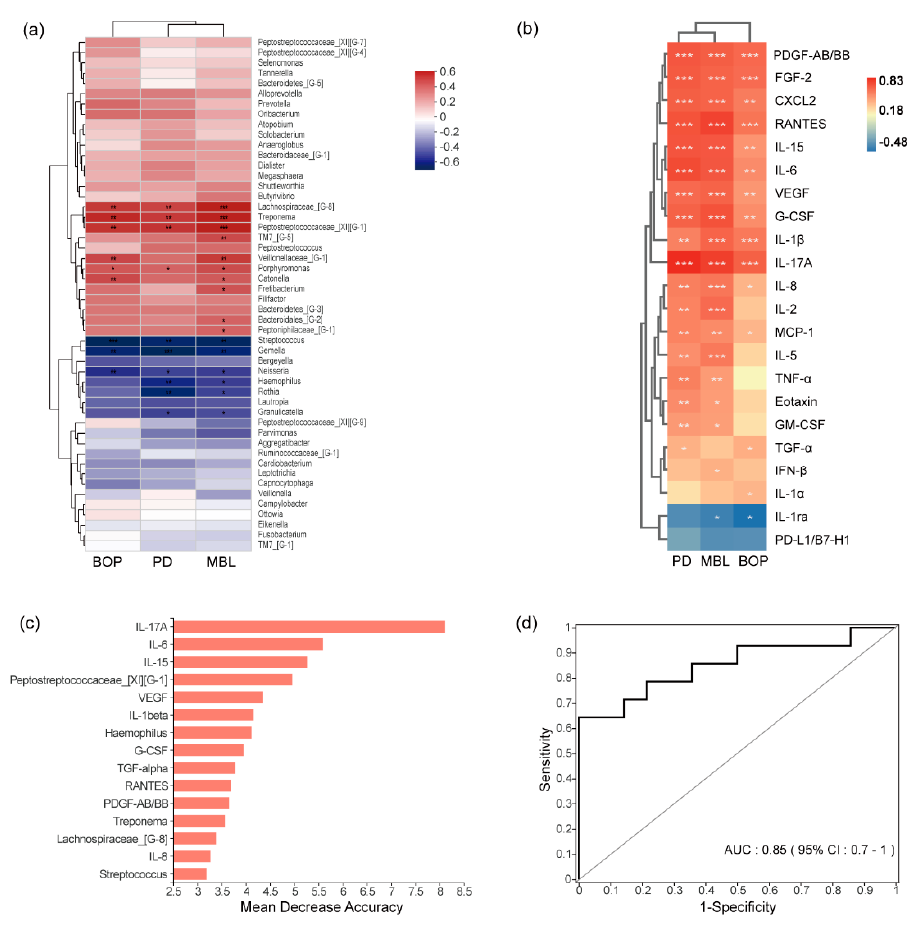
Figure 3. The heatmap shows the correlations between clinical indexes (PD, BOP, MBL) and the top 50 genera ( a ) and the differential cytokines between healthy implants and peri − implantitis ( b ) analyzed with Spearman’s correlation coefficient. The top 15 genera and cytokines of the optimal model were constructed by random forest classification ( c ). The receiver operating characteristic (ROC) curve was used to evaluate the constructed model ( d ). * p < 0.05, ** p < 0.01, *** p < 0.001. PD, probing depth; BOP, bleeding of probing; MBL, marginal bone loss; AUC, the area under the curve.